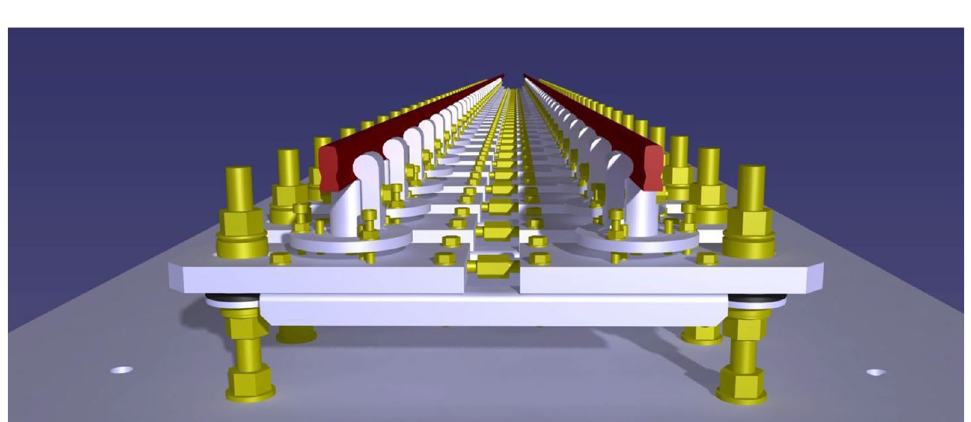
Figure 5. 3D render view of the designed